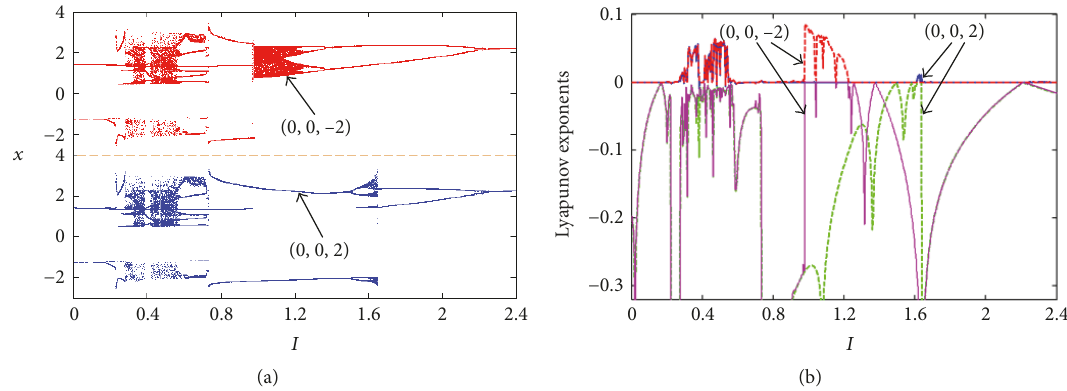
Figure 6: For the initial values (0, 0, − 2) and (0, 0, 2), hidden coexisting asymmetric behaviors with 𝐼 = 0 ∼ 2.4 and 𝑘 = 0.9. (a) Bifurcation diagrams of 𝑥 . (b) First two Lyapunov